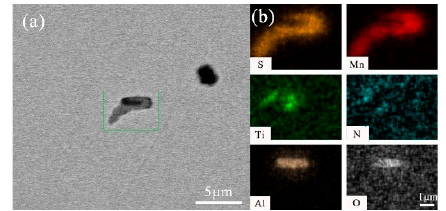
Figure 7. Typical MnS patterns pinned by TiN with oxide as the core ( a ) SEM morphology of in- clusions; ( b ) composition distribution of inclusions.